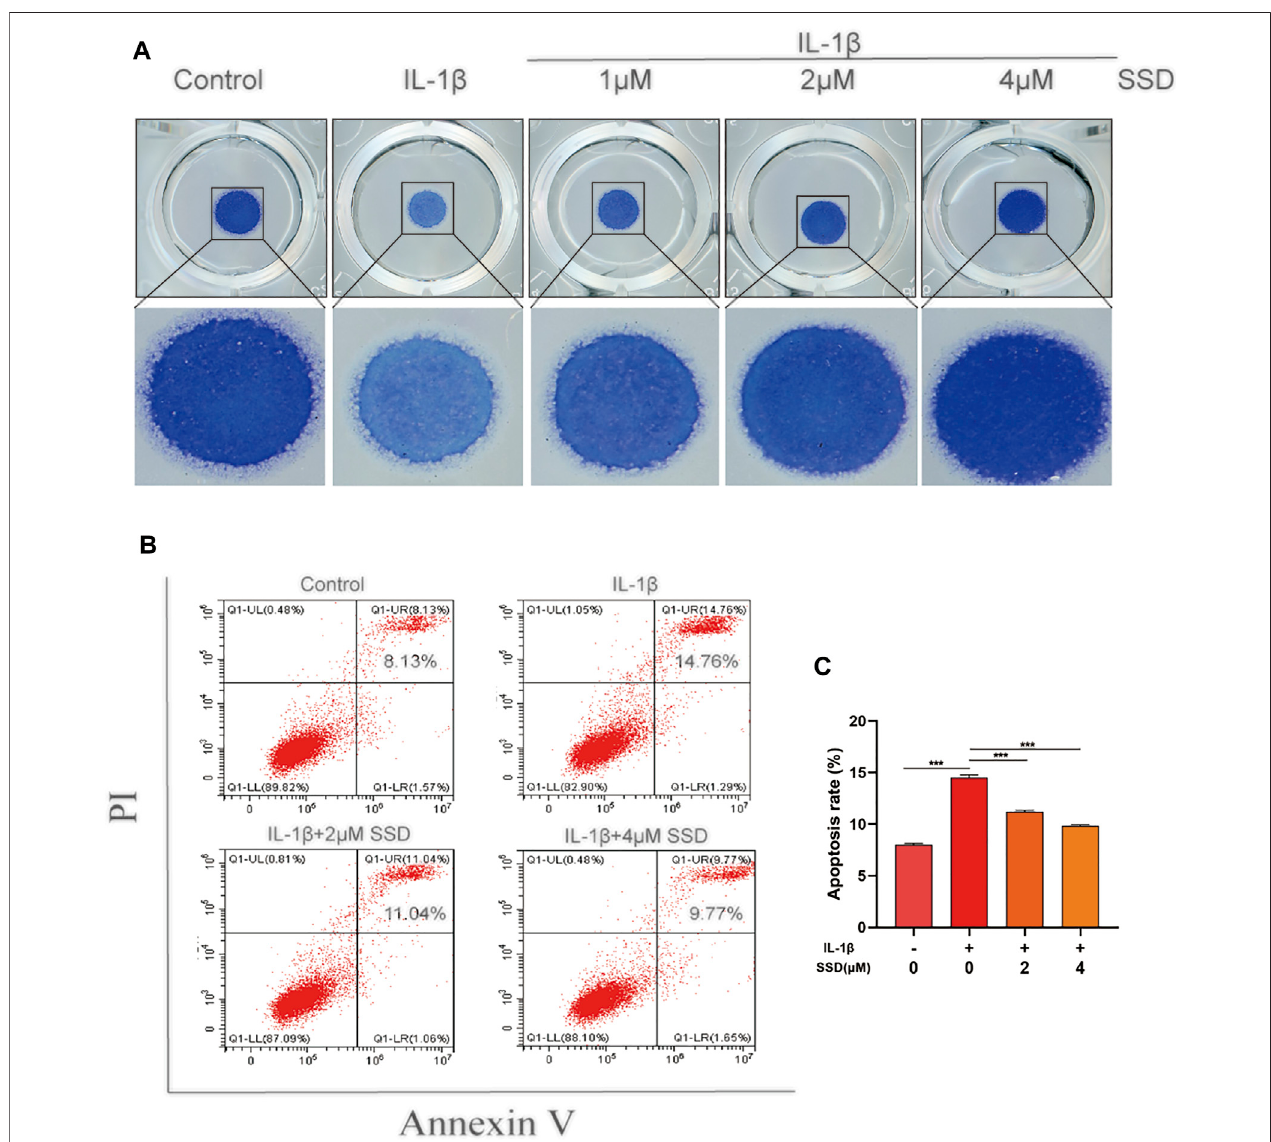
FIGURE2| SSDpreventedIL-1 β – induceddifferentiatedATDC5chondrocyteapoptosis. (A) Thecells(density,10 8 /ml)stimulatedbyIL-1 β wereseededin24-well plates and treated with or without different concentrations of SSD for 5 days. Images of the cells stained with toluidine blue o solution. (B) The cellular apoptotic ratios in different groups were quanti fi ed by fl ow cytometry. (C) Statistical analysis of the cellular apoptosis results between groups. Mean ± SD was applied with all data. The experiments in vitro were performed independently at least 3 times. *** p < 0.001, ** p < 0.01, * p < 0.05.